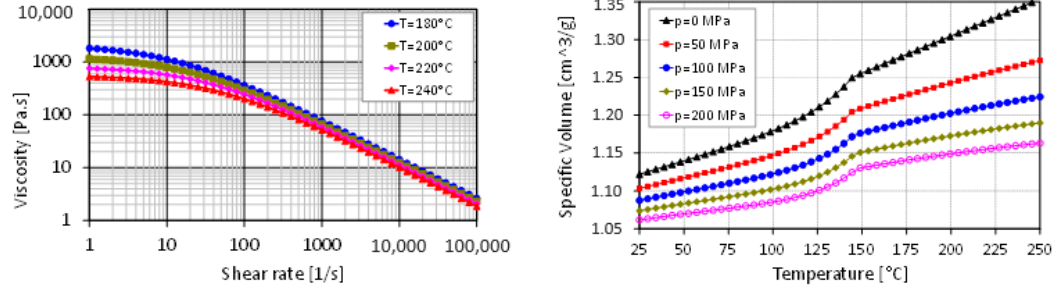
Figure2. Viscosityplot(Left)andpressure-specificvolume-temperatureplot(Right)ofthethermoplastic Figure 2. Viscosity plot (Left) and pressure-specific volume-temperature plot (Right) of the elastomer material used in the injection and micro injection moulding thermoplastic elastomer material used in the injection and micro injection moulding experiments.